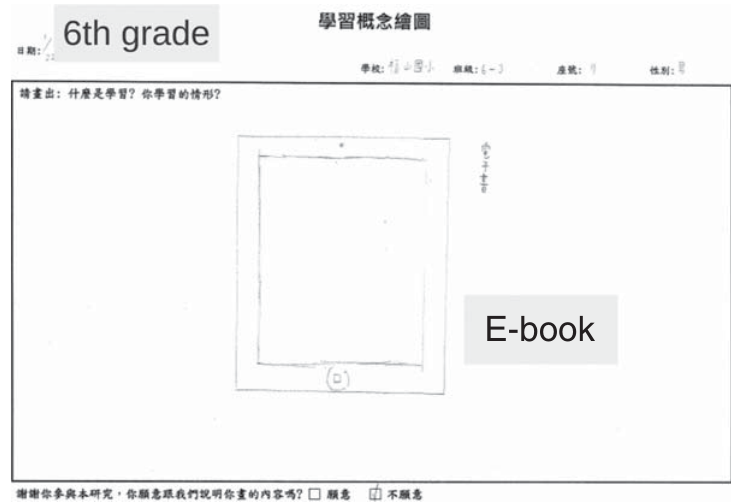
Figure 9. A drawing by a